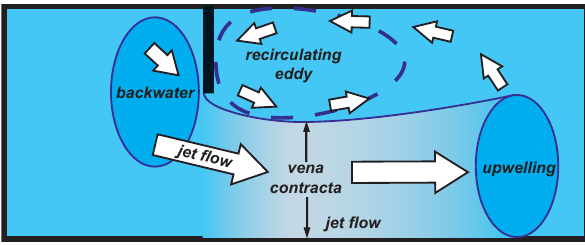
Fig. 1. Plan view of conceptual model of vena-contracta formation.